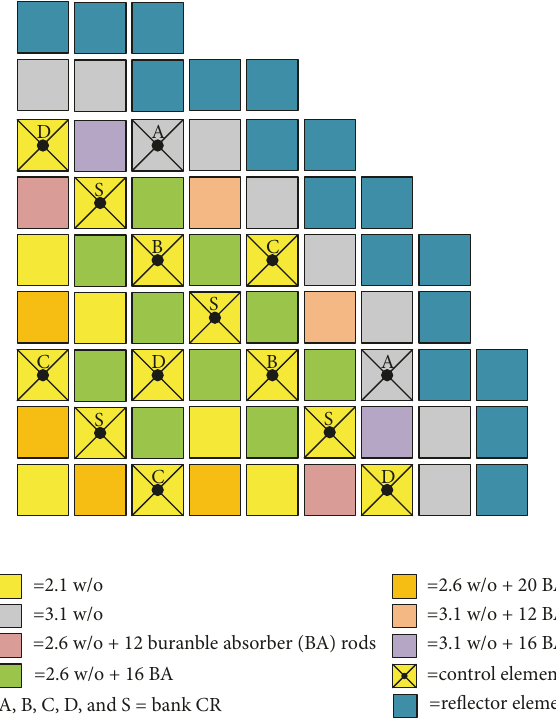
Figure1:TheNEA-NSCPWRuncontrolledCRswithdrawalbench- mark core configuration